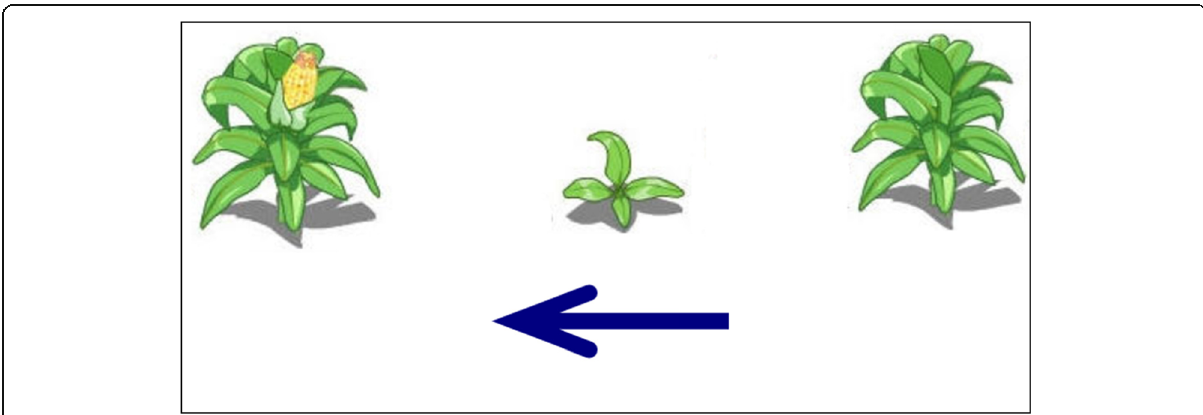
Fig. 6 An example of a horizontal space-time incompatible target. This is an instance of a false